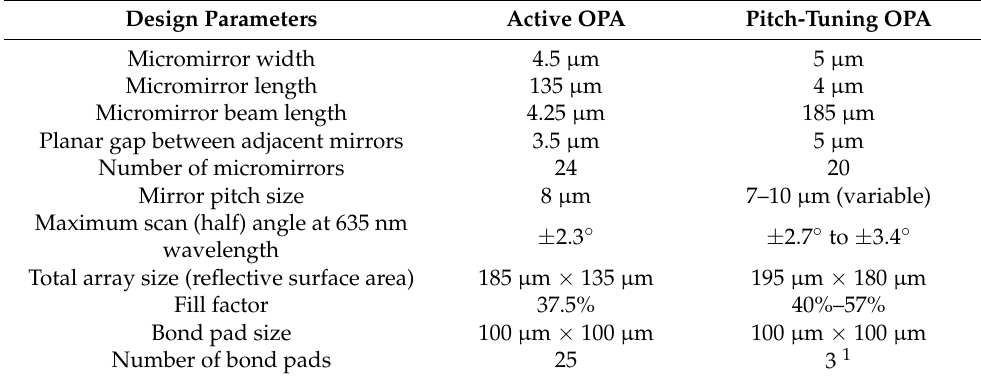
Table 1. Design specifications for the Microelectromechanical System (MEMS)-Based Optical Phased Array (OPA)